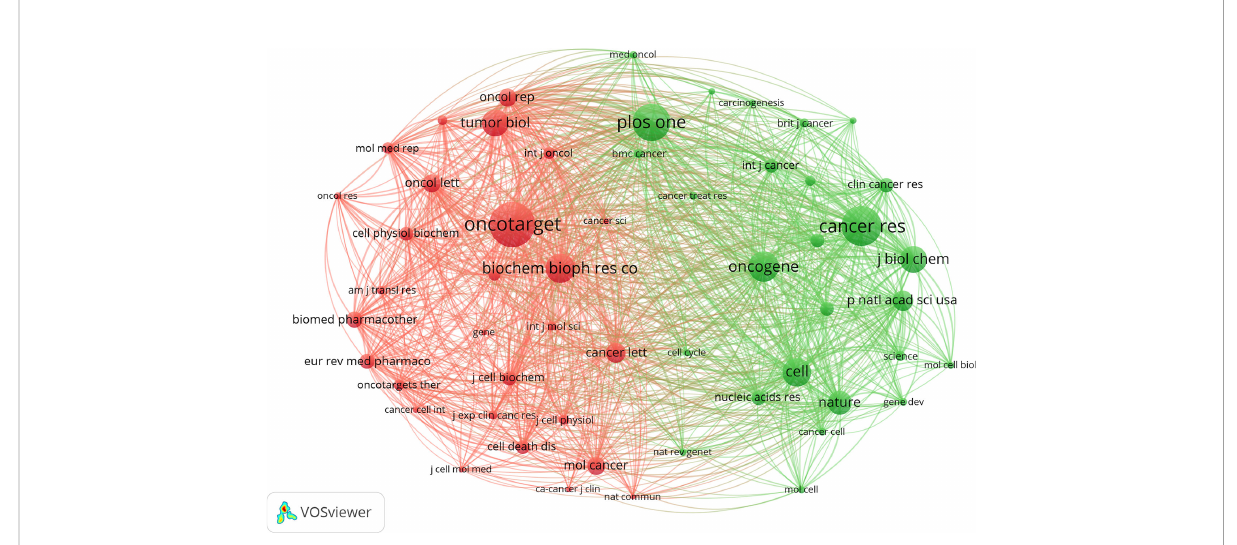
FIGURE 5 The network visualization map of journal co-citation analysis by VOSviewer. The explanation of the nodes and links in the map is identical to that described in Figure